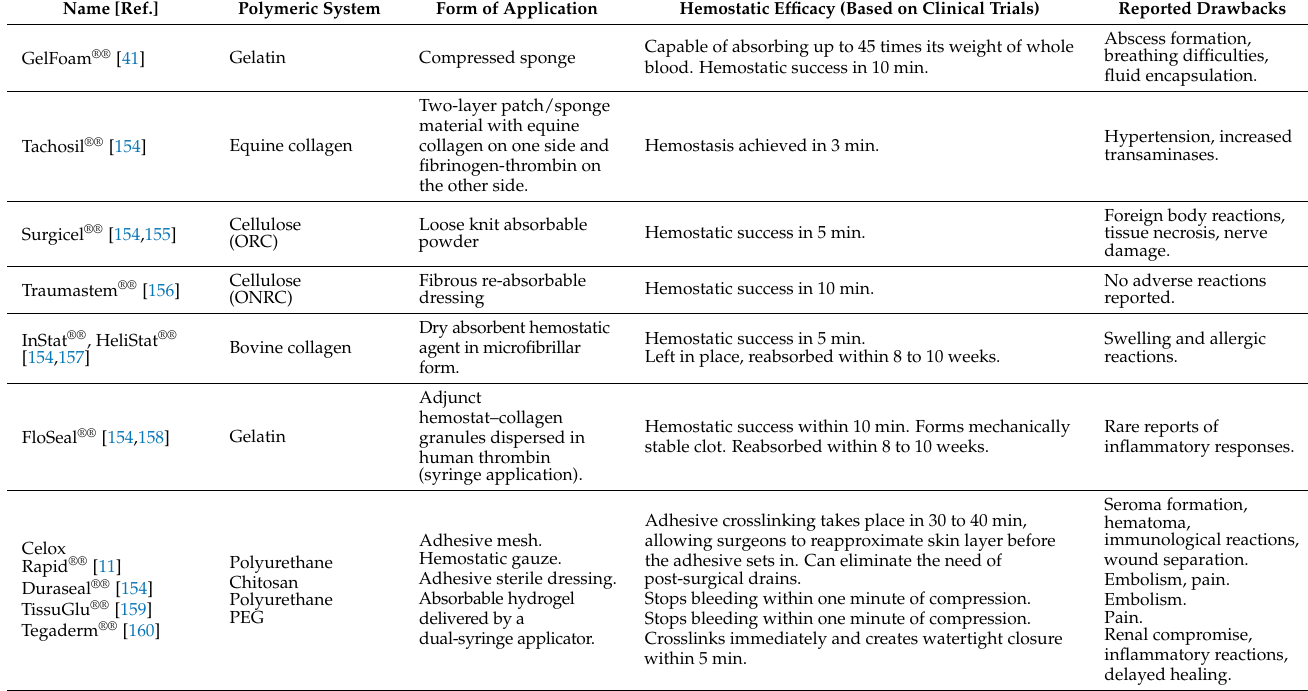
Table 3. Commercially available polymer-based hemostatic